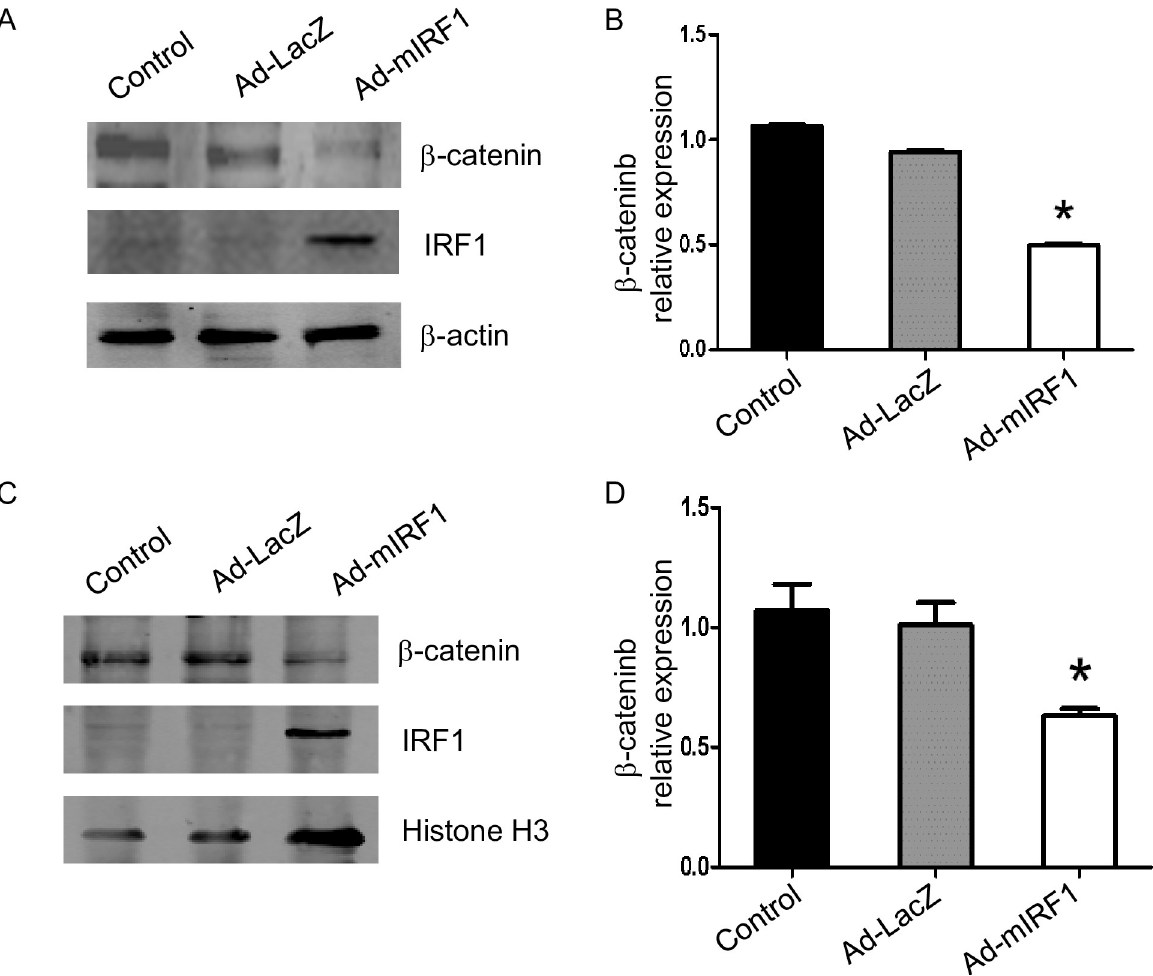
Fig 5. IRF1 inhibits β -catenin expression in primary liver cells. Primary liver cells of B6 mouse were infected with Ad-mIRF1 for 48 h and the cytoplasm protein (A and B) and nuclear proteins (C and D) of β -catenin and LC3A/B were detected by Western blot and densitometric analysis. n = 3, data are presented as mean ± SD, � P <